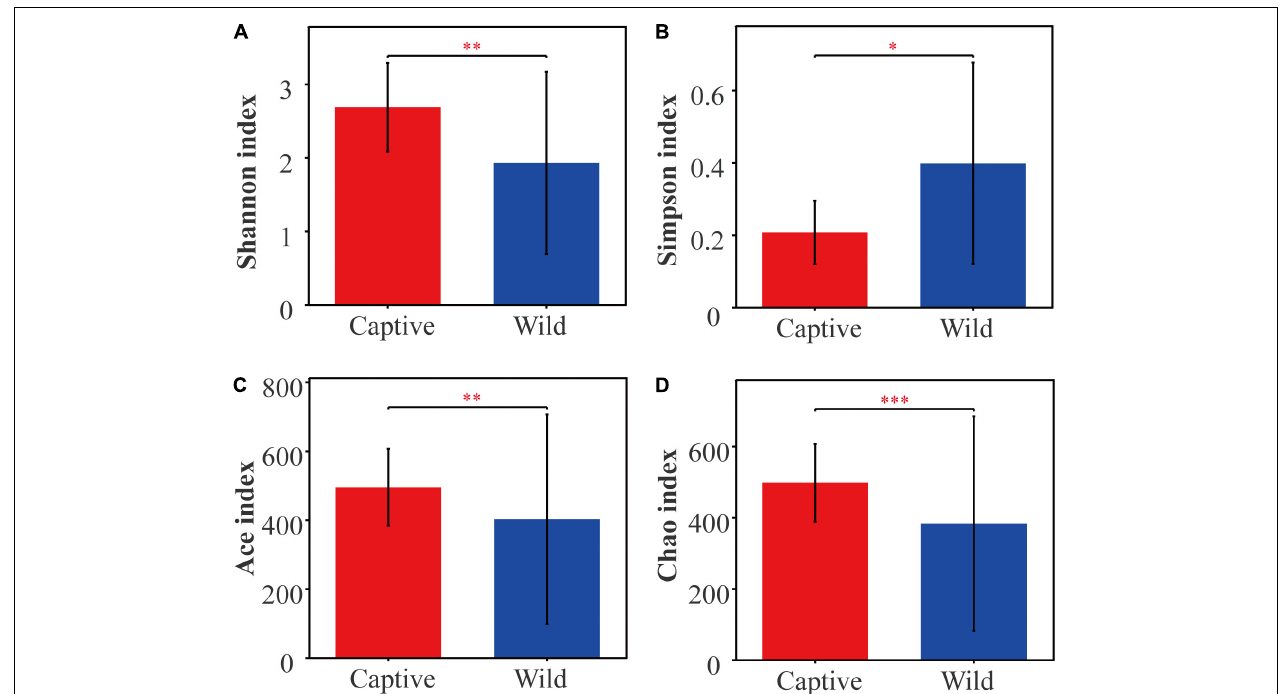
FIGURE 1 | Alpha diversity of gut microbiota between captive and wild geckos. (A) Shannon index; (B) Simpson index; (C) Ace index; (D) Chao index. Significant difference 0.01 < p ≤ 0.05 was marked as “*”, 0.001 < p ≤ 0.01 was marked as “**”, and p ≤ 0.001 was marked as “***”.